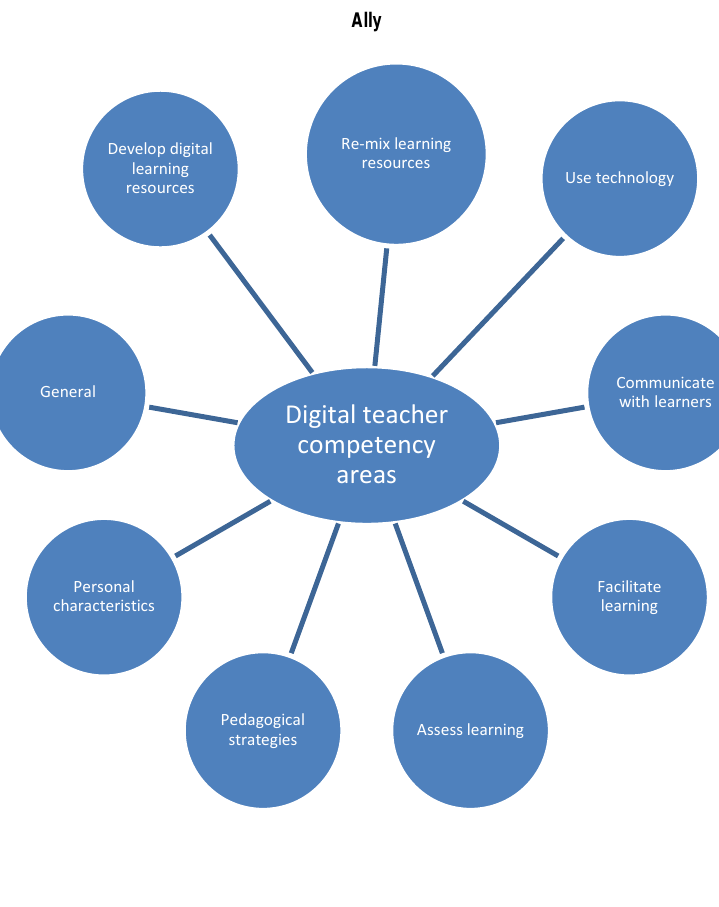
Figure 2. Major areas of responsibilities for the digital teacher of the future. Competencies Required by Digital Teachers for Future Education